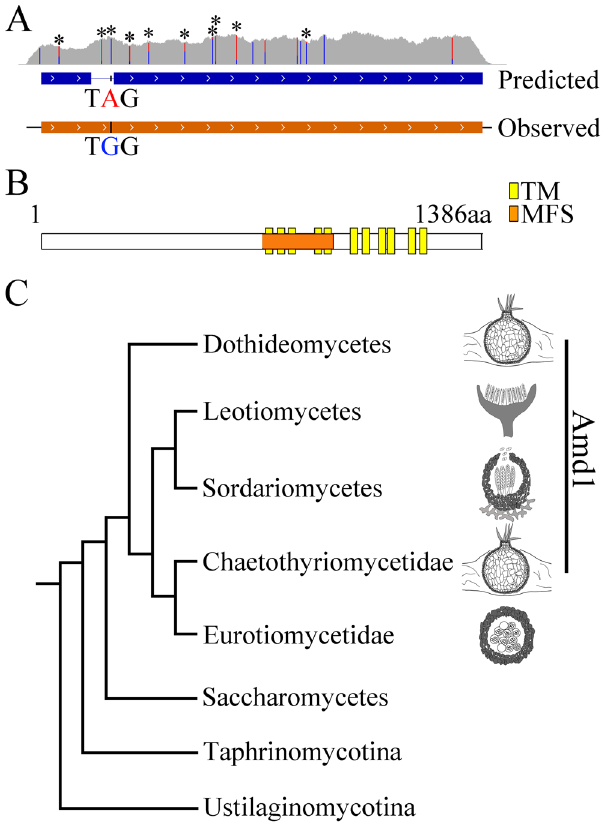
Figure 1. Editing sites and domain structures of AMD1 and its phylogenetic distribution. (A) Transcripts in RNA-seq data, the predicted gene model, and observed coding region of AMD1 . The actual gene model contains one stop codon UA 632 G in the incorrectly predicted intron that was edited to UG 632 G. Reads coverage from RNA-seq data was in gray shade. Blue and red vertical lines represent the edited and unedited portions of AMD1 transcripts at each editing site, with nonsynonymous editing sites marked with asterisks. ( B ) The Amd1 protein contains one major facilitator superfamily (MFS) domain (aa. 618–840) and 11 transmembrane helixes (TM). ( C ) The distribution of Amd1 orthologs is restricted to Sordariomycetes (perithecium), Dothidiomycetes (pseudothecium or ascostrama), Leotiomycetes (apothecia), Chaotothriomycetidae (ascostroma) and Eurotiomycetidae (cleistothecia) species of